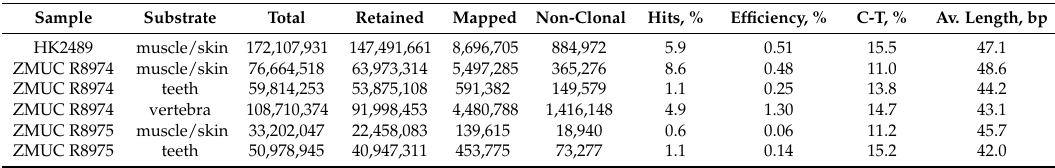
Table 1. Sequencing and molecular preservation of three Z. longissimus museum